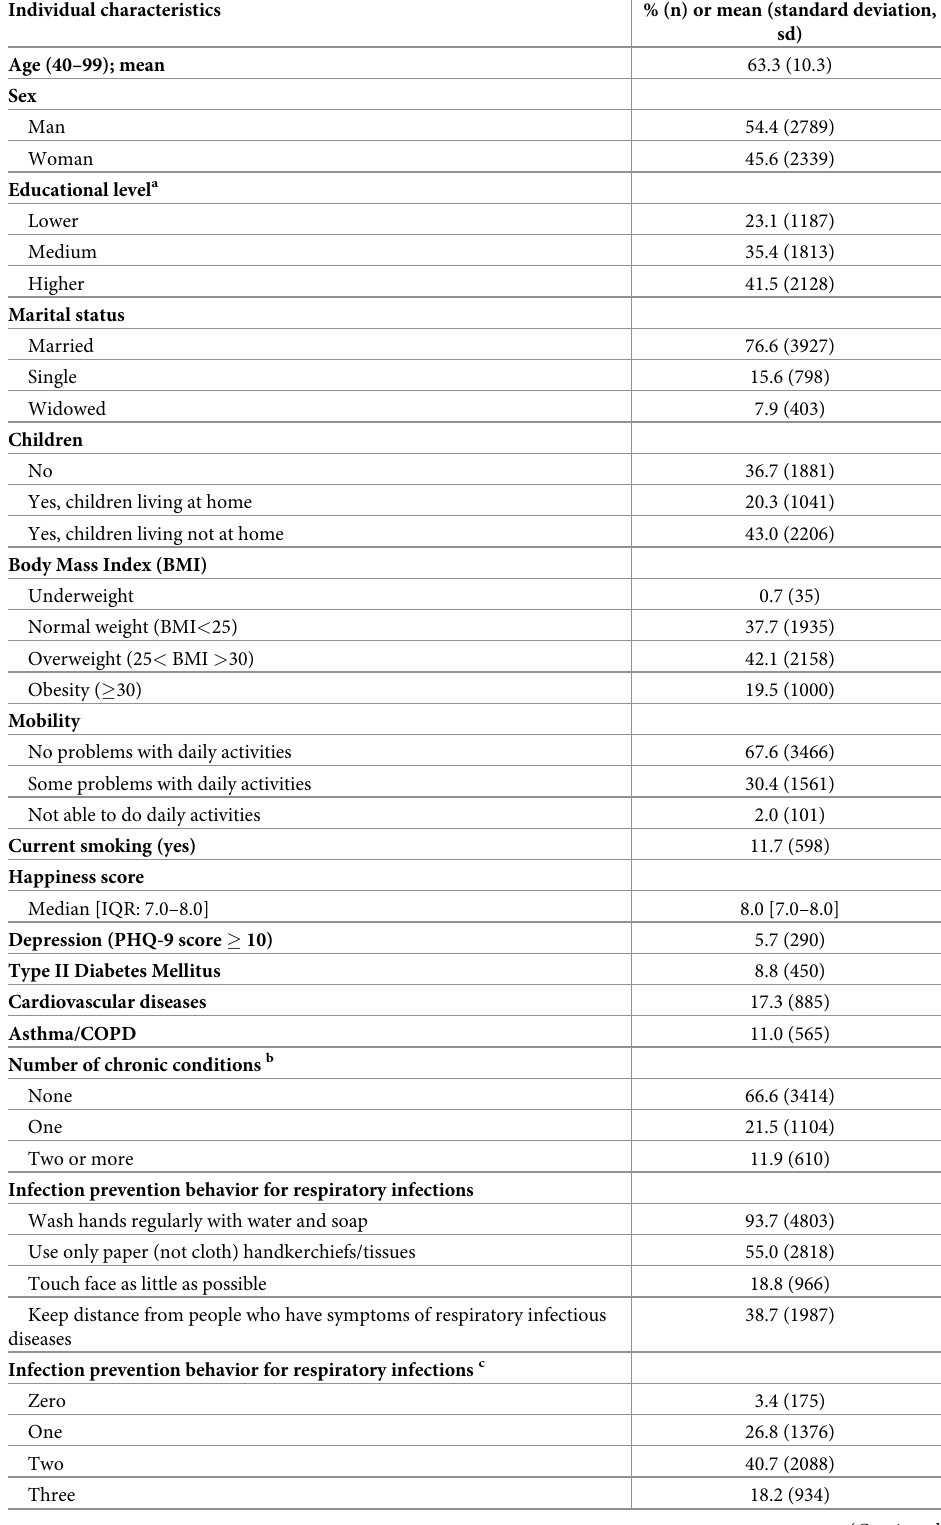
Table 1. Characteristics of the SaNAE study population (n =